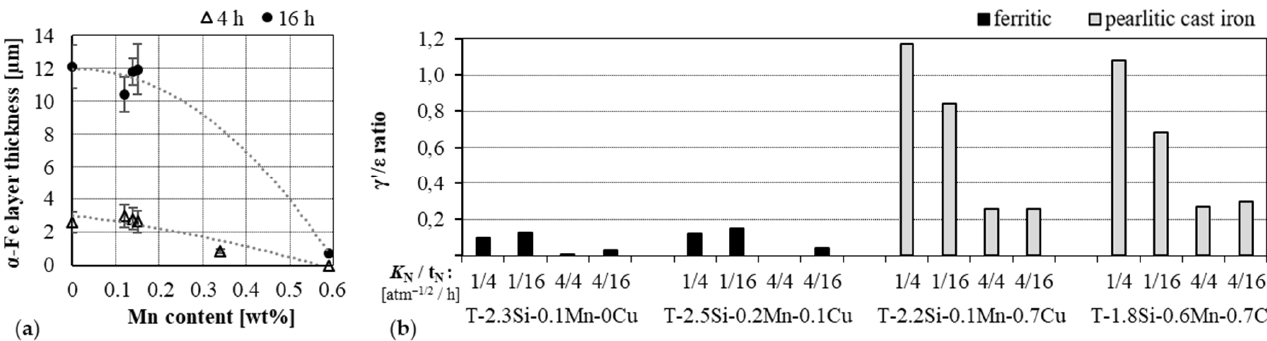
Figure 9. Effect of alloying elements Mn and Cu in EB remelted cast iron materials after nitriding at 540 °C for the indicated times and ( a ) K N = 0.1 atm − 1/2 (decarburization) on the thickness of the α -Fe layer measured by SEM (BSE contrast) on the transformed eutectic cementite (curves drawn as an orientation guide) and ( b ) indicated K N values on the γ ’/ ε ratio (calculated from XRD measurement data in wt%).